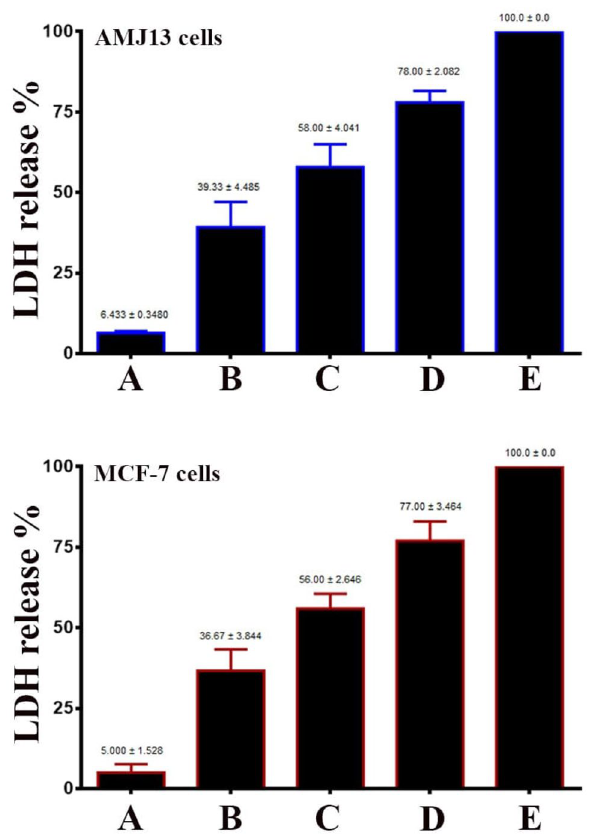
Figure 3. CuO NPs increase the release of lactate dehydrogenase (LDH) production. ( A ) control untreated cells. ( B ) Cells treated with 25 µg cells mL −1 of CuO NPs. ( C ) Cells treated with 50 µg cells mL −1 of CuO NPs. ( D ) Cells treated with 100 µg cells mL −1 of CuO NPs. 1% Triton-x was employed for positive control reference ( E ). LDH release was measured at 490 nm. Results are represented as mean ±